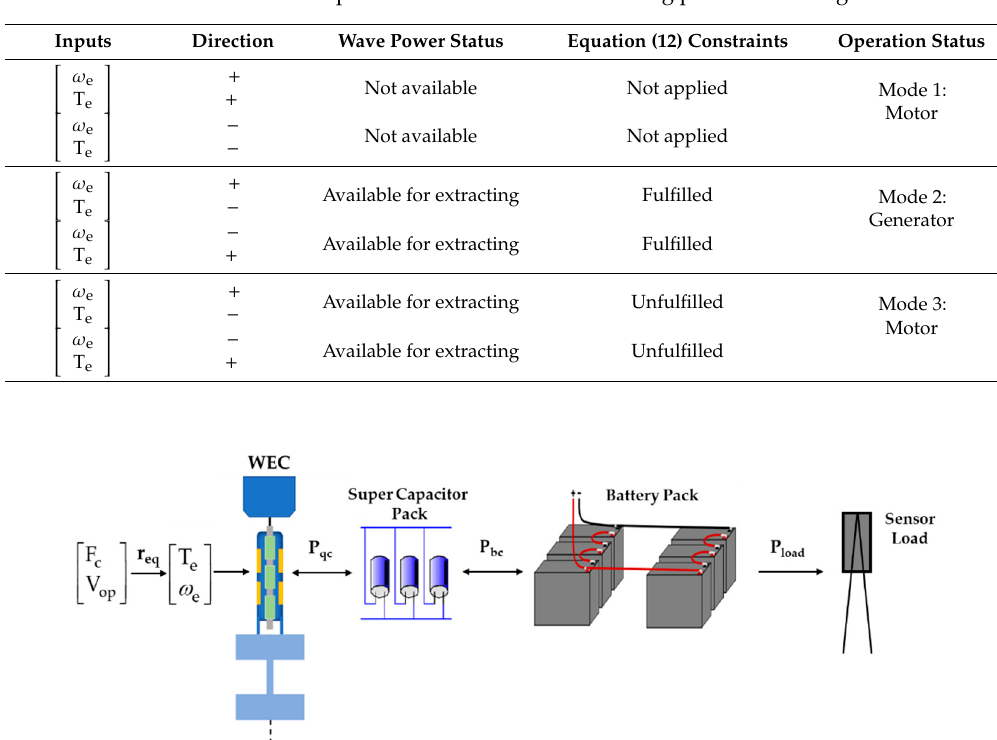
Table 2. Electrical machine operation modes while considering power extracting constraint. Inputs